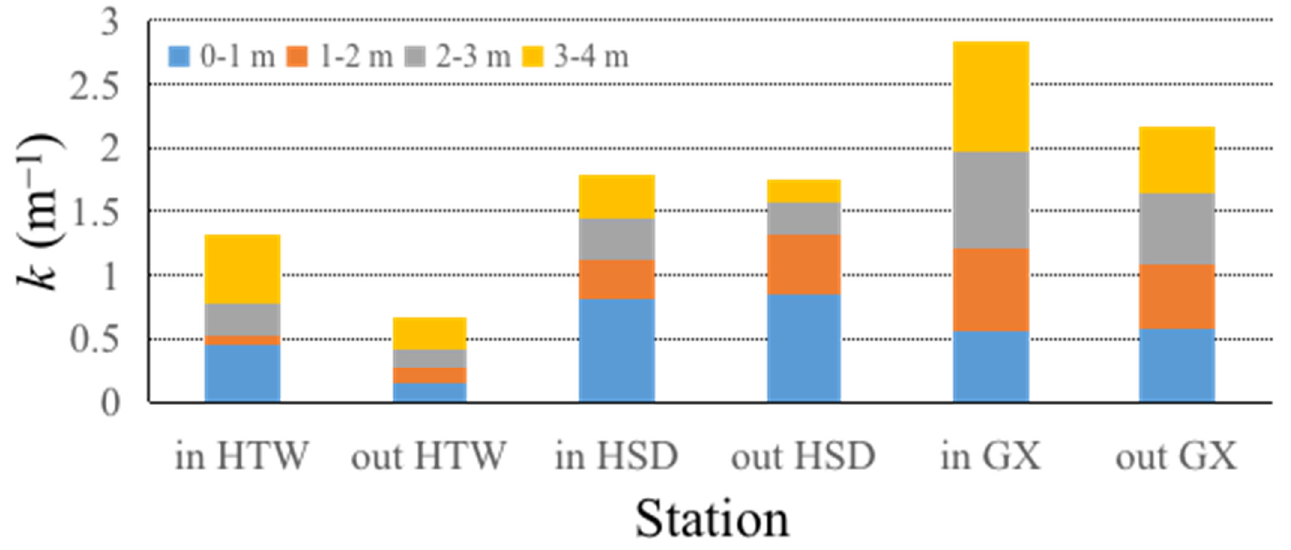
Figure 2. Comparison of light attenuation rate k (m − 1 ) inside and outside the beds at 1.0 m intervals (0–1 m, 1–2 m, 2–3 m, 3–4 m) in HTW (Houtouwan), HSD (Huangshidong), and GX (Ganxie) on 29 May in 2010. ‘In’ means inside the bed; ‘Out’ means outside the bed.